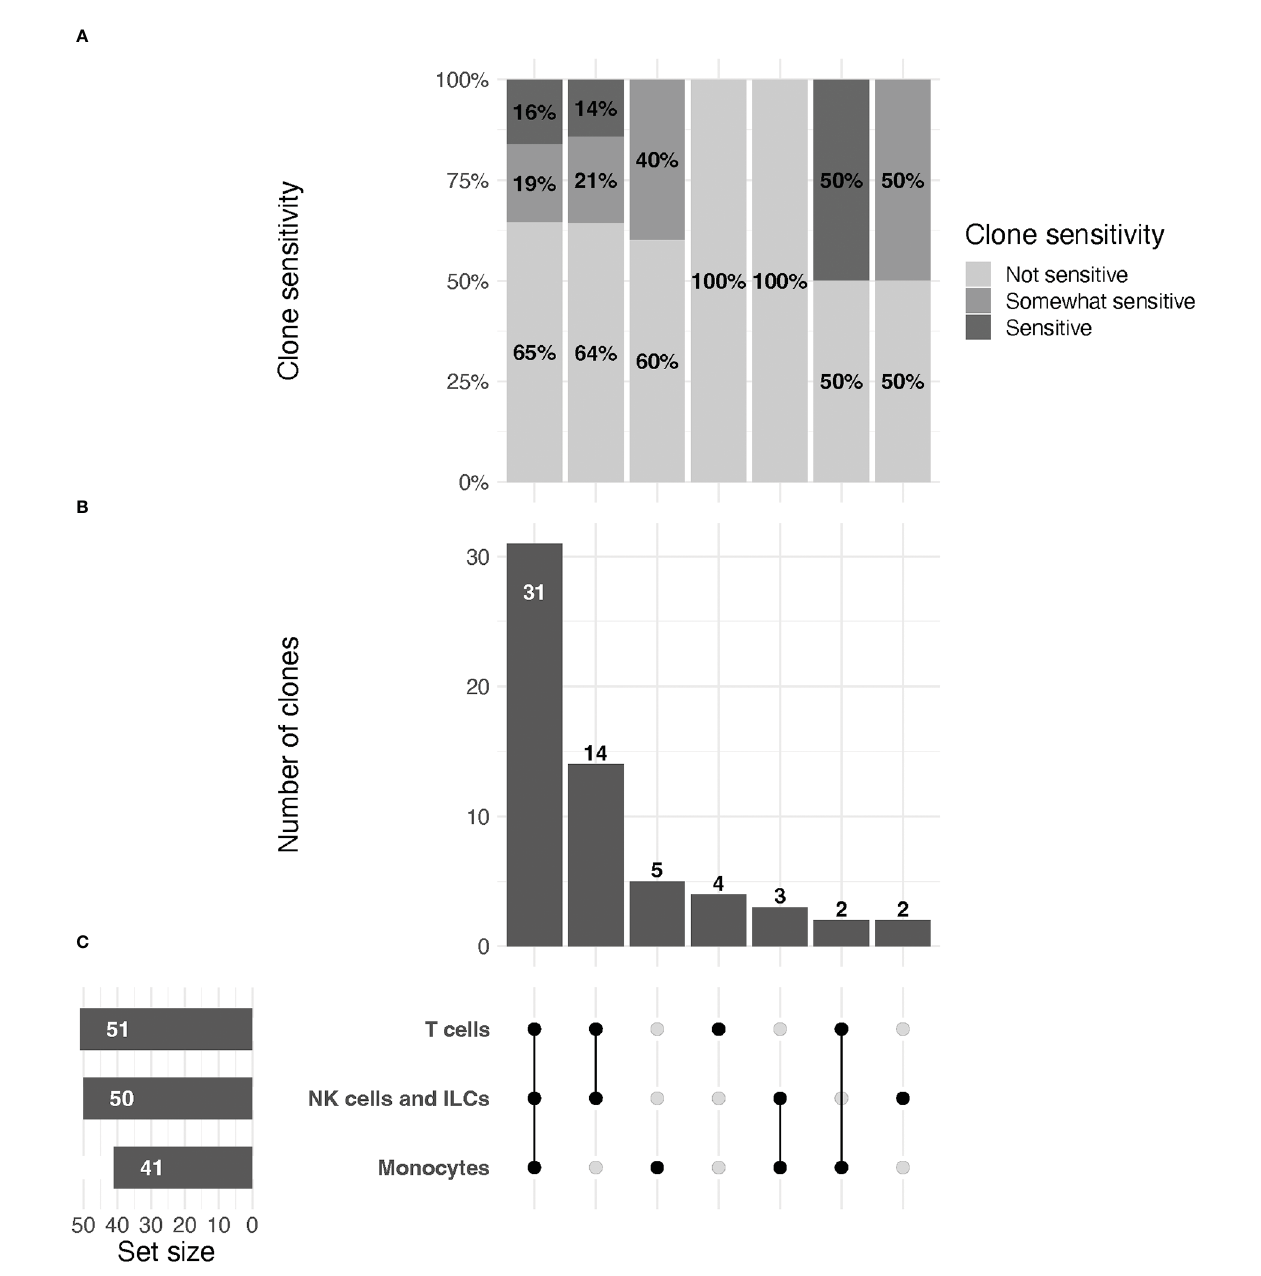
FIGURE 2 UpSet plot of clones included in the study, organized by immune cell lineage (T cell, NK/ILC, or monocyte). (A) Relative proportions of sensitive, partially sensitive, and insensitive clones per grouping. (B) Histogram representing number of clones tested per grouping. ( C , left) From top to bottom, total number of clones tested for markers that are expressed by T cells, NK/ILCs, and monocytes, respectively. Line plot (right) signi fi es groupings of markers for data in (A, B) that are expressed by one, two, or all three cell types, as indicated by connected dots (e.g., the fi rst column describes data for markers that are expressed by all three cell types, the second column for markers expressed only by T cells and NK/ILCs, etc.). Groupings are